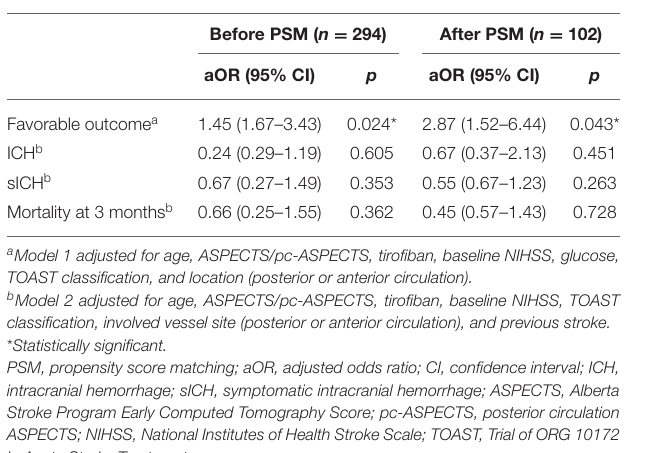
TABLE 2 | Multivariate regression analysis of effects of tirofiban on safety and efficacy outcomes.